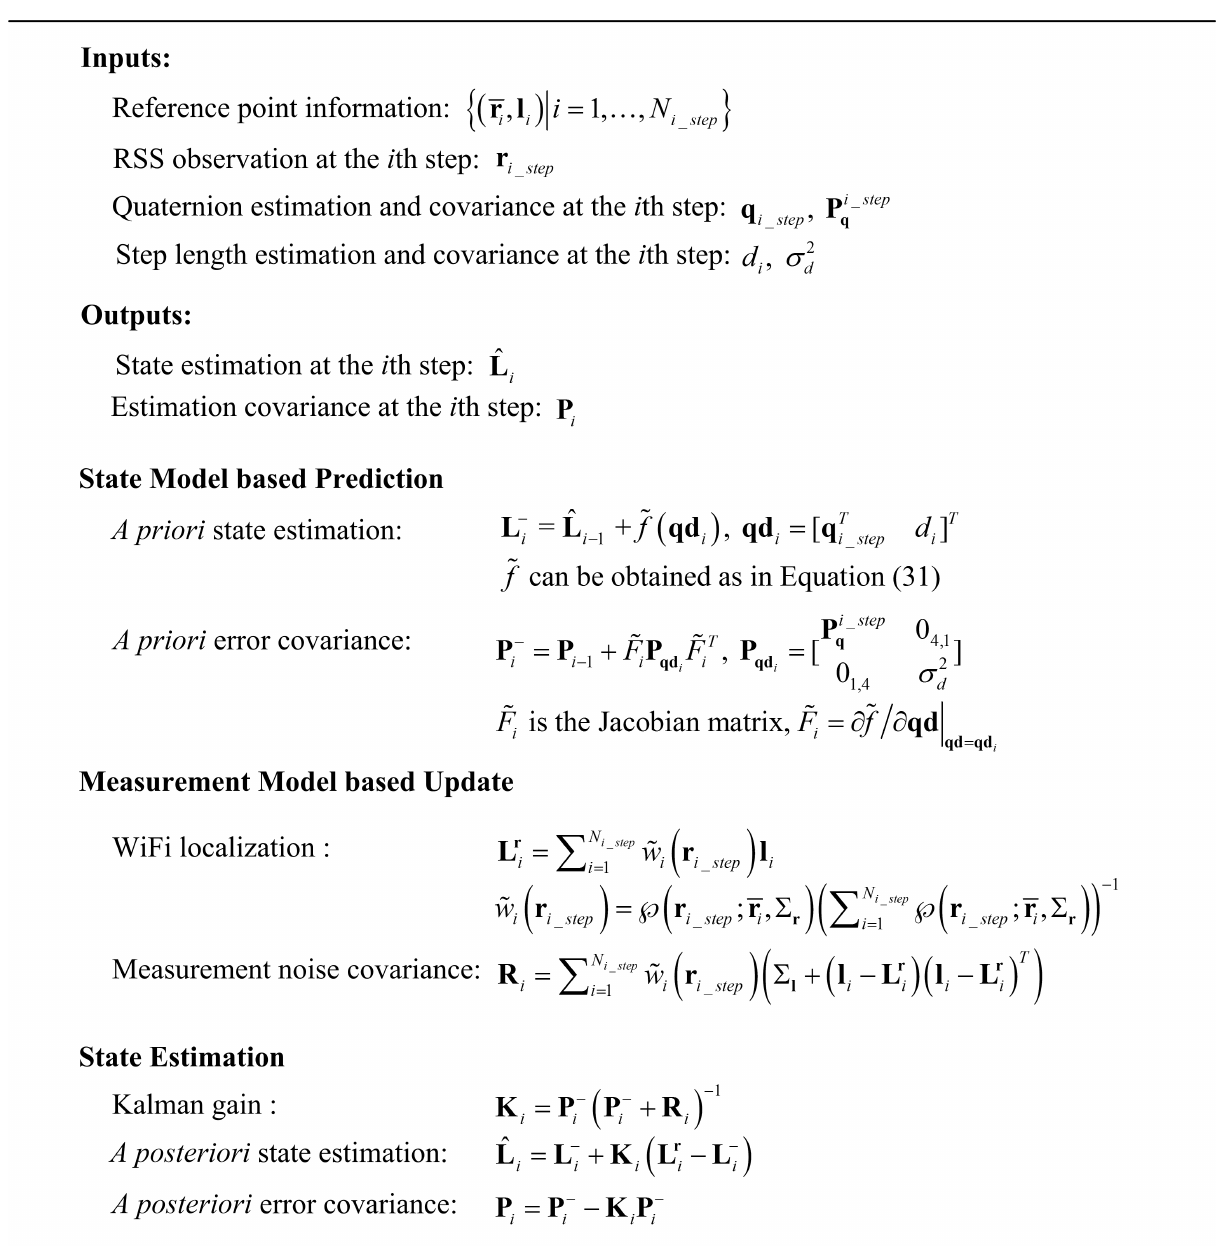
Figure 3. Summary of the second EKF for fusing WiFi localization and